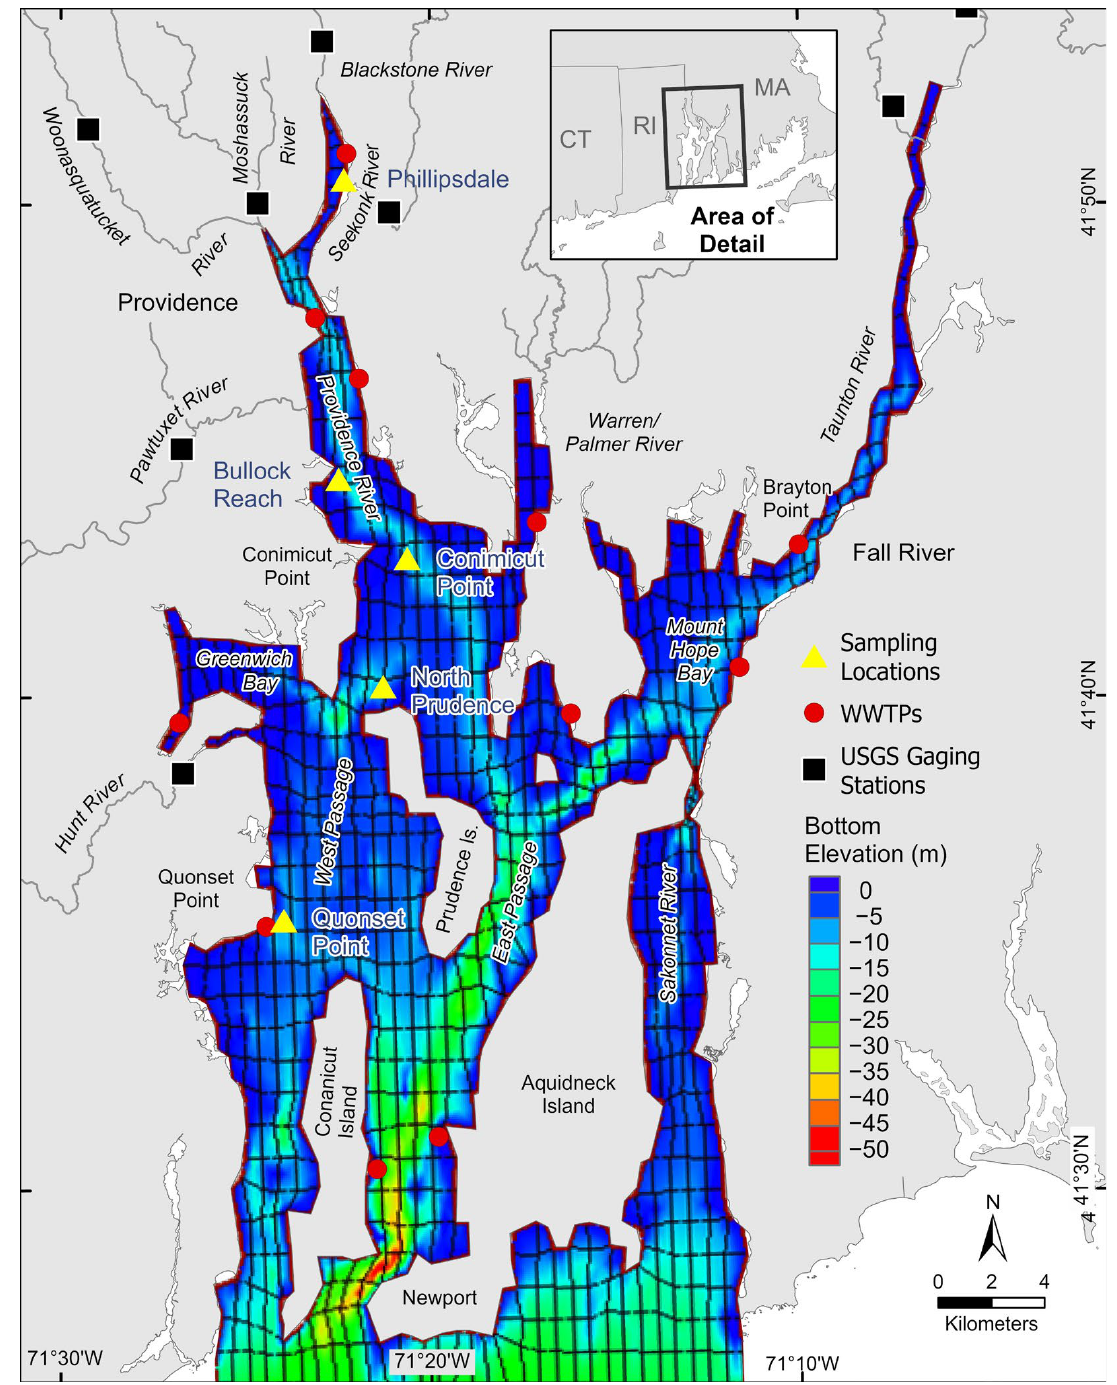
Figure 2. Narragansett Bay WASP Model domain. with bottom elevation ( adapted [35] ) . Sampling locations ( solid yellow triangle ) for dissolved oxygen and chlorophyll a , from north to south: Phillipsdale, Bullock Reach, Conimicut Point, North Prudence, Quonset Point ( adapted [28] ) . Wastewater Treatment Plants ( WWTPs ) are marked by red disks and tributary inflows are marked by solid black squares [35,36] .